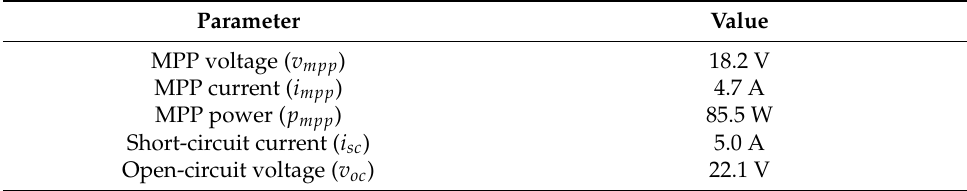
Table 1. Datasheet parameters of the BP585 PV panel.